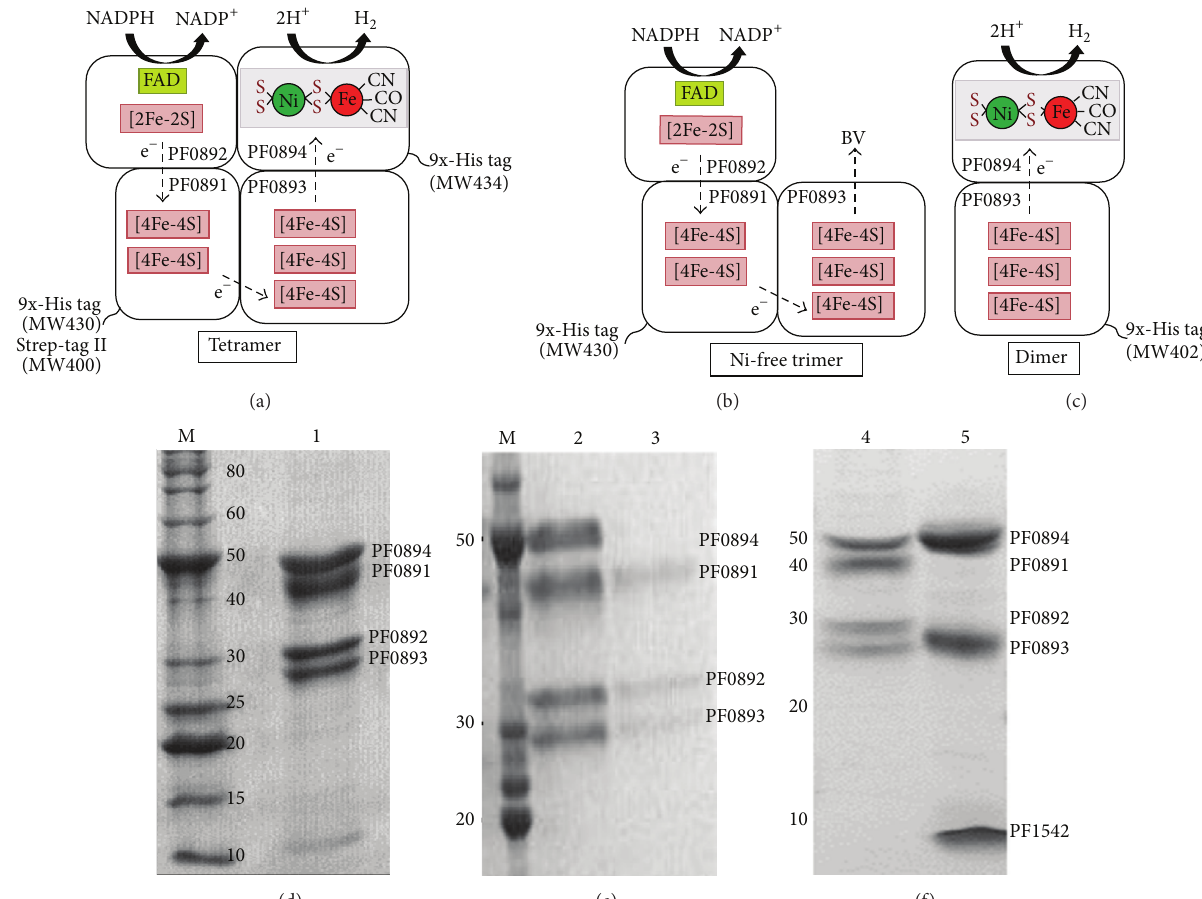
Figure 1: Models of tetrameric (a), Ni-free trimeric (b), and dimeric (c) forms of SHI. These are modified from [10] and are based on the cofactor and iron-sulfur cluster contents in sequence analysis. The proposed electron flow from NADPH oxidation to hydrogen evolution is also shown. Four different strains of P. furiosus were constructed to obtain the various forms of SHI. They are designated as MW400, MW430, MW434, and MW402 and their properties are listed in Table 2. These were used to prepare PF0891 Strep-tag II SHI [11], PF0891 9x-His tag SHI [12], PF0894 9x-His tag SHI [12], and PF0893 9x-His tag dimeric SHI [13], respectively. SDS PAGE gels show the purity of the different forms: (d) lane 1, Strep-tag II tetrameric SHI; (e) lane 2, 9x-His tag tetrameric SHI; lane 3, 9x-His tag Ni-free trimeric SHI; (f) lane 4, native SHI; lane 5, 9x-His tag dimeric SHI (PF1542 is an unrelated protein that is a persistent contaminant that copurified with dimeric SHI). The SDS PAGE gel data were modified from [11–13].